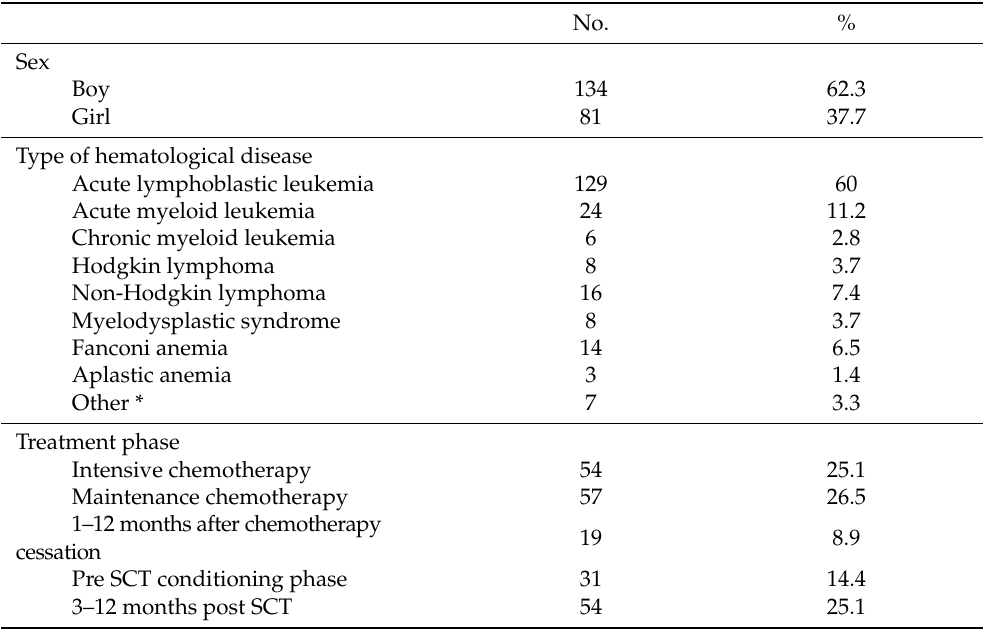
Table 1. Patient characteristics at physiotherapy assessments (n =